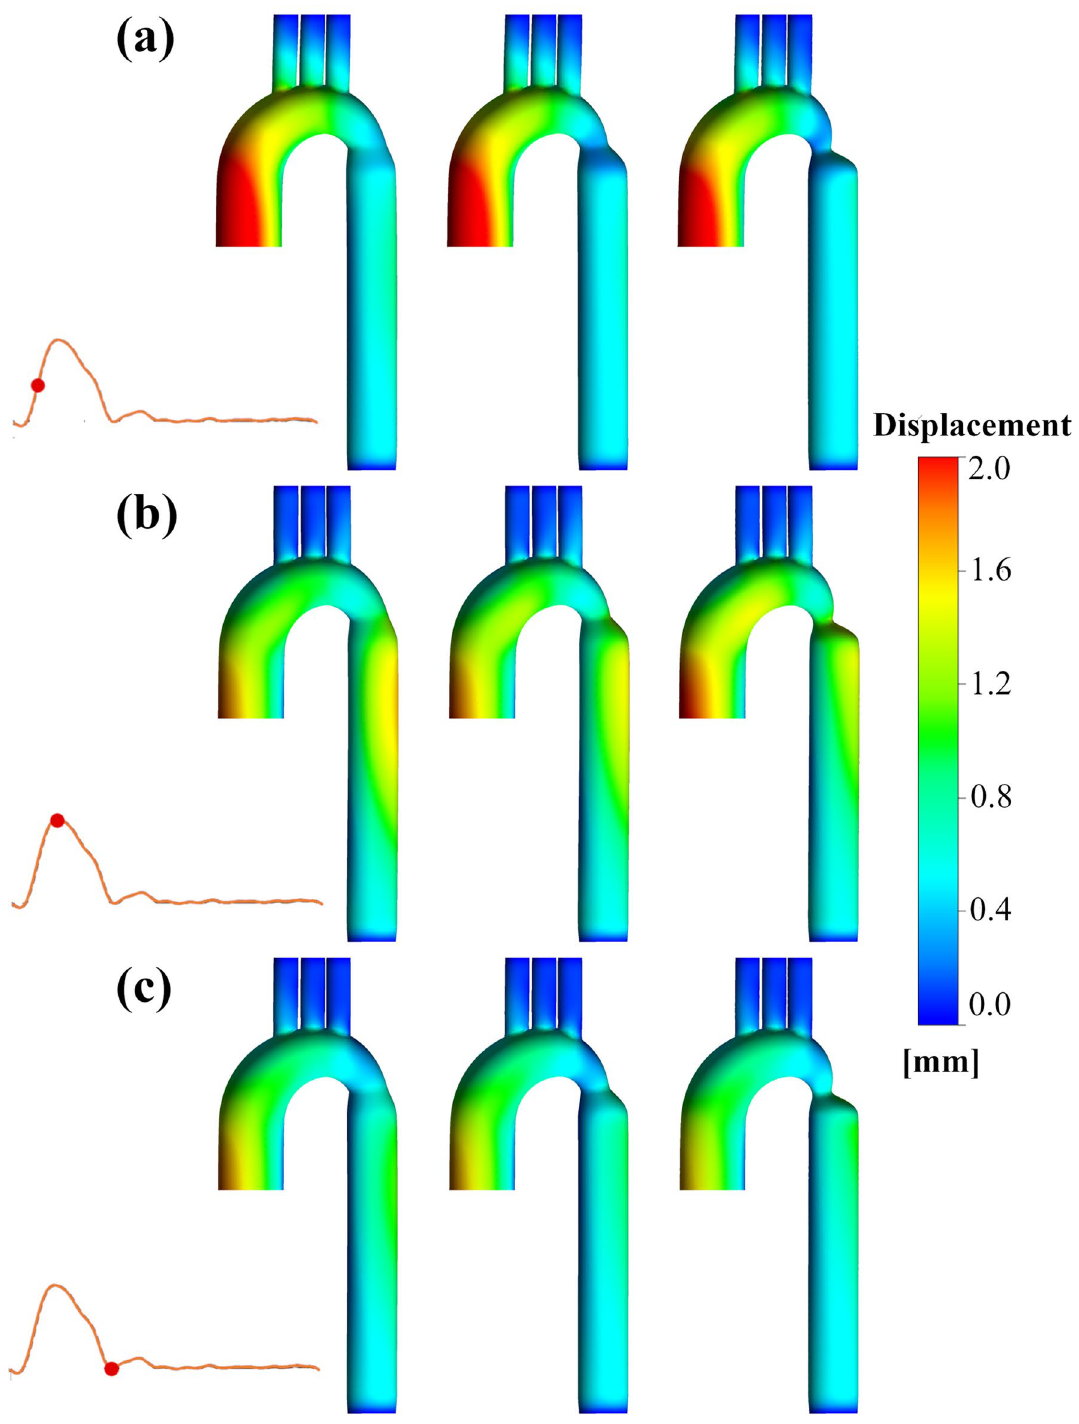
Figure 2. Vessel wall displacement during the cardiac cycle. Contours demonstrate the displacement of the geometry in the right anterior view at ( a ) mid-systole, ( b ) peak systole, and ( c ) dicrotic notch (left: 25% coarctation, middle: 50% coarctation, right: 75%